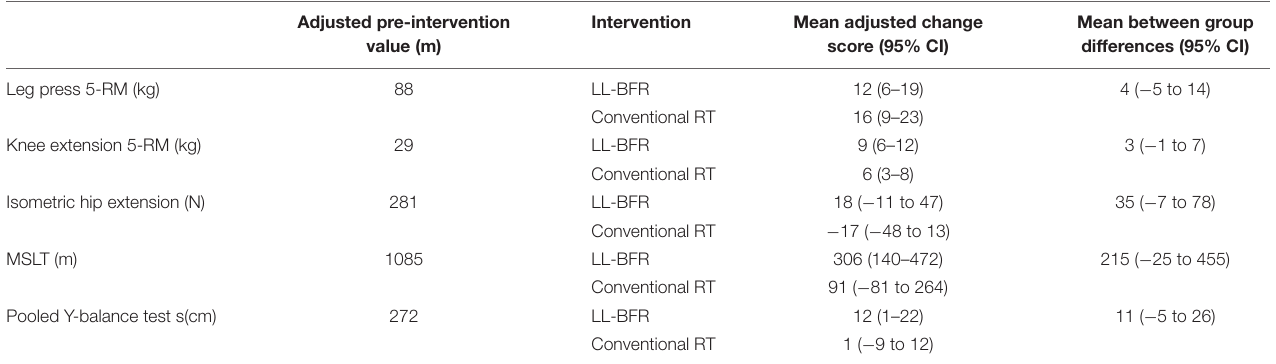
TABLE 4 | Post-intervention values and change score of muscle strength and functional test after adjusting for differences in values scored at baseline (using analysis of covariance—ANCOVA). Adjusted pre-intervention value (m)